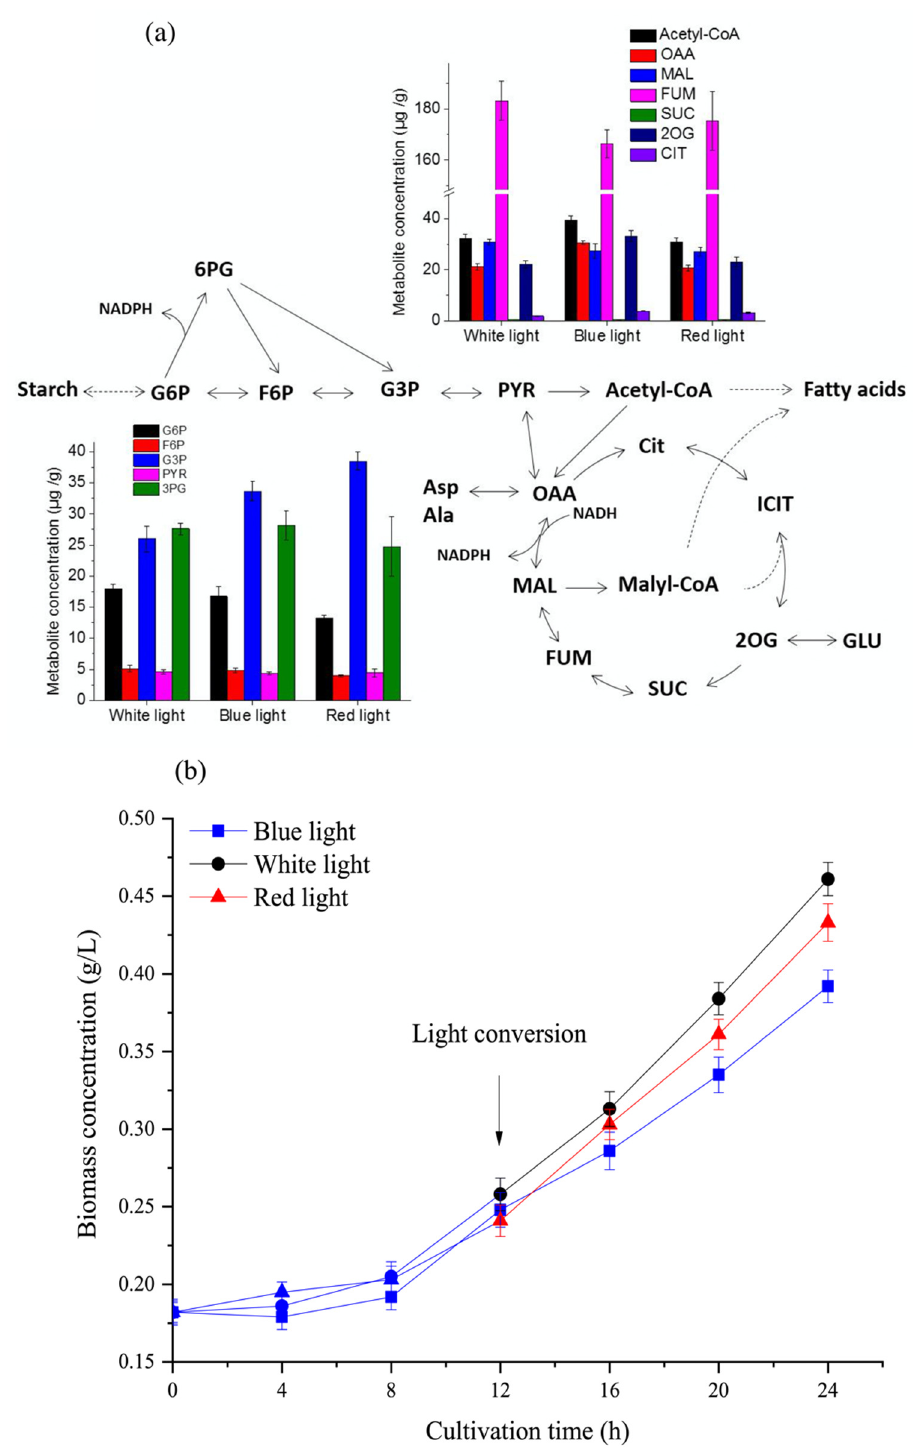
Figure 6. ( a ) Various metabolites of C. reinhardtii at different light wavelengths at 12 h of N-recovery. The carbon metabo- lites are the following: G6P, glucose-6-phosphate; F6P, fructose-6-phosphate; G3P, glyceraldehyde-3-phosphate; 3PG, 3-phosphoglycerate; PYR, pyruvate; OAA, oxaloacetate; MAL, malate; FUM, fumarate; SUC, succinate; 2OG, 2-oxoglutarate; and CIT, citrate. ( b ) Effect of light conversion at 12 h of cultivation on biomass concentration of C. reinhardtii . Data of metabolite concentration and biomass concentration are presented in the form of mean ± the standard deviation ( n = 3).